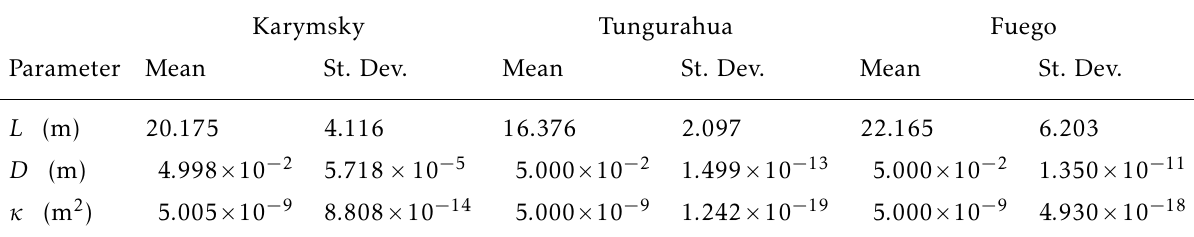
Table 2 – Output parameters from the oscillating gas pocket model [Girona et al. 2019]. Values were calculated using an iterative Nelder-Mead algorithm and averaged across the same sequences described in Table